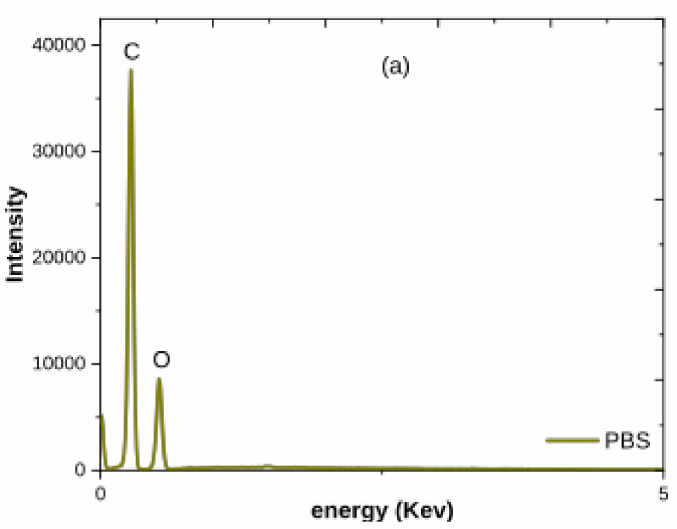
Figure 5. SEM micrographs for ( a ) PBS, ( b ) L-proline and ( c ) PBSLP.